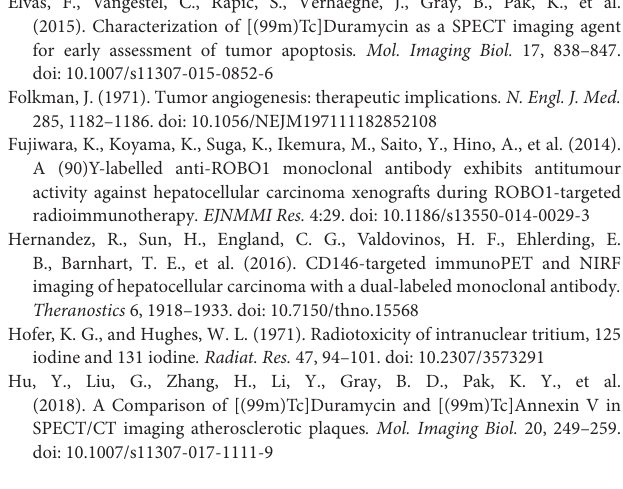
Figure S1 | The radiochemical purity (96.3%) of 125 I-AA98 mAb was assessed by radio-thin layer